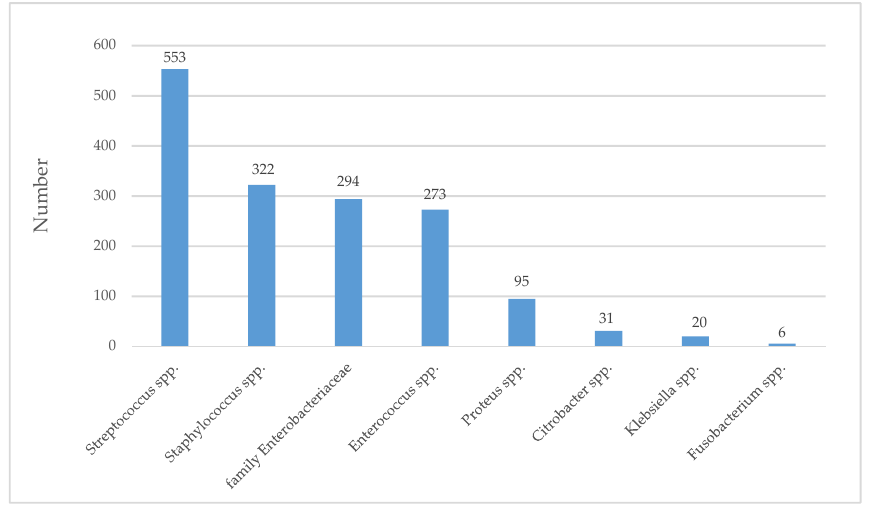
Figure 2. Commonly isolated bacteria from DFIs using culture-based methodS. The number on the bar is the sum of the total number of isolated bacterial genus in 10 studies from 2004 to